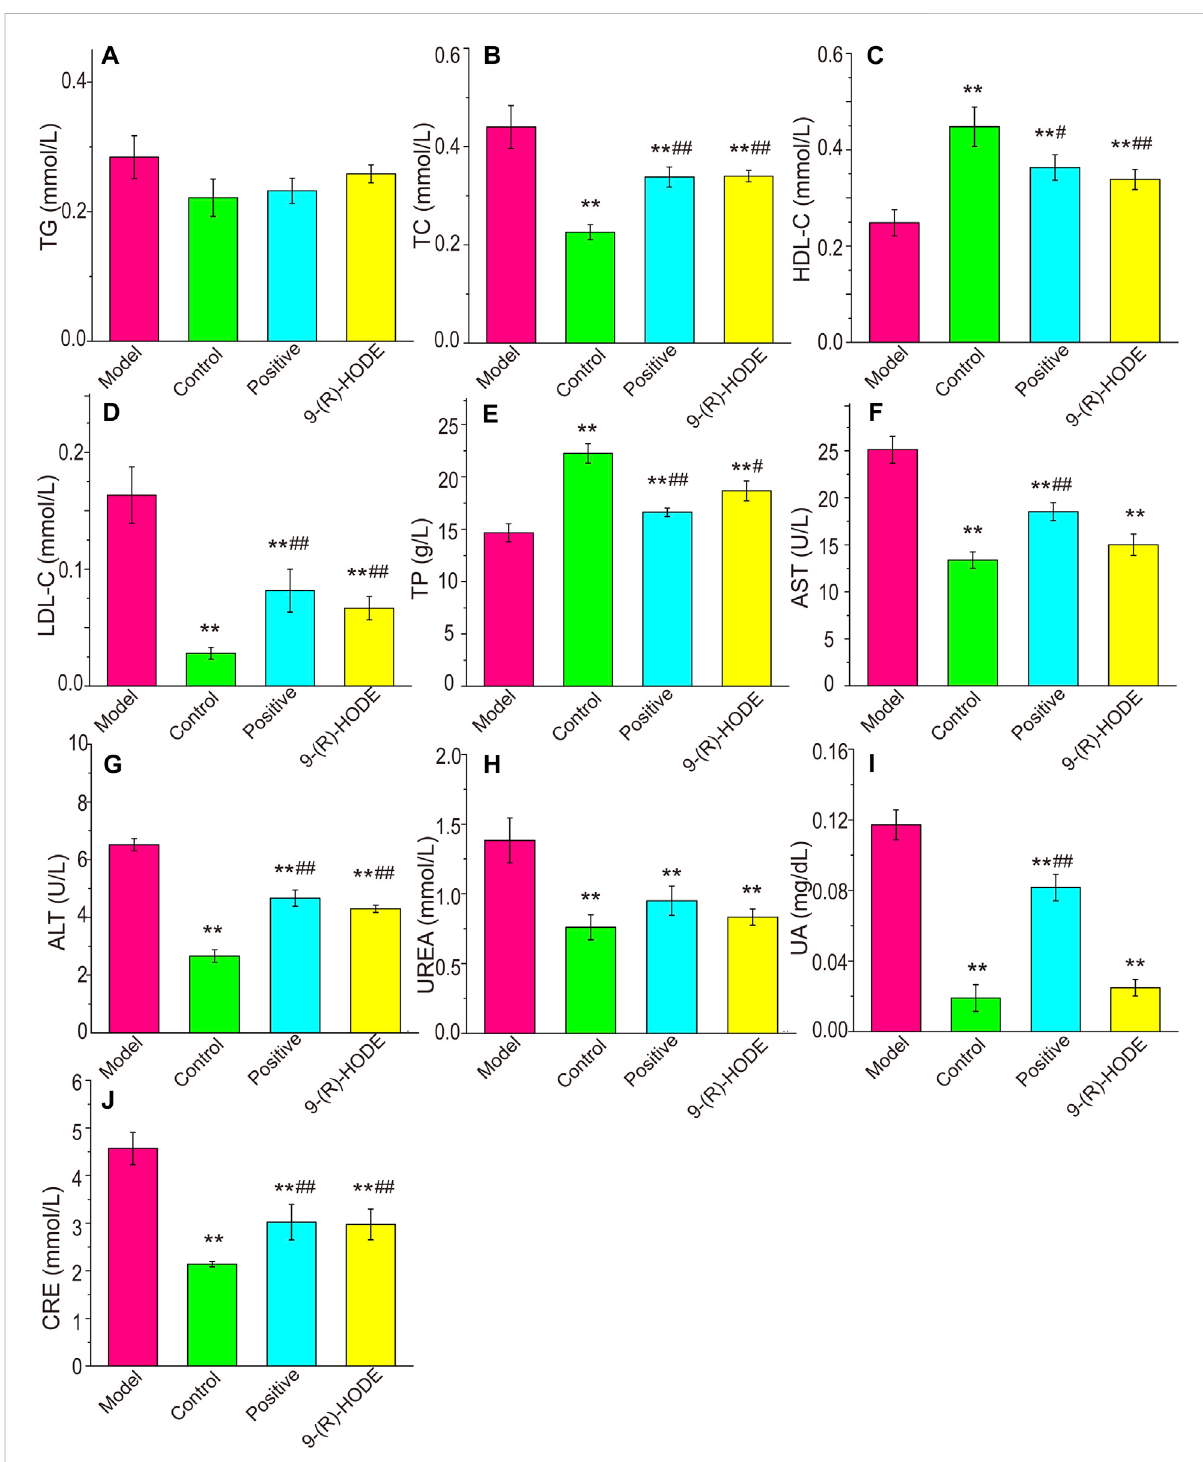
FIGURE 2 Effectsof9-(R)-HODEonTAG (A) ,TC (B) ,HDL-C (C) ,LDL-C (D) ,TP (E) ,AST (F) ,ALT (G) ,UREA (H) ,UA (I) andCRE (J) plasmalevelsofmice; *p < 0.05, **p < 0.01, signi fi cantly different from the model group; #p < 0.05, ##p < 0.01, signi fi cantly different from the control